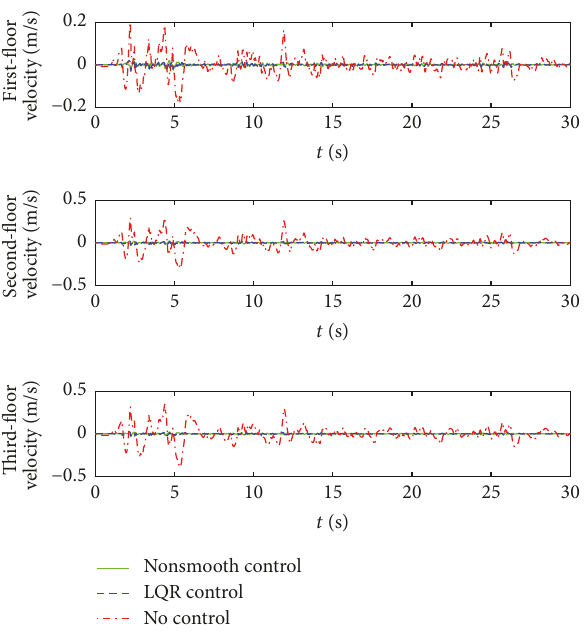
Figure 7: Velocity response of example